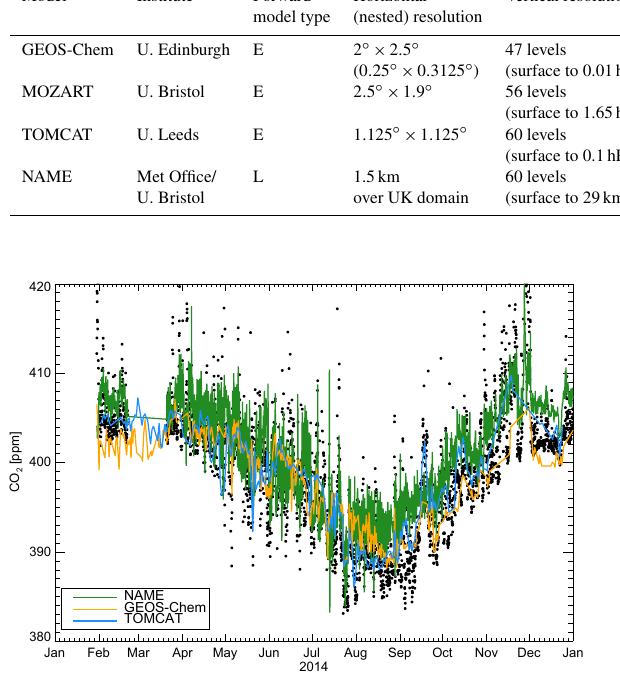
Table 7. Model descriptions used in the GAUGE intercomparison. Forward model types include Eulerian (E) and Lagrangian (L). Model Key references model type (nested) resolution